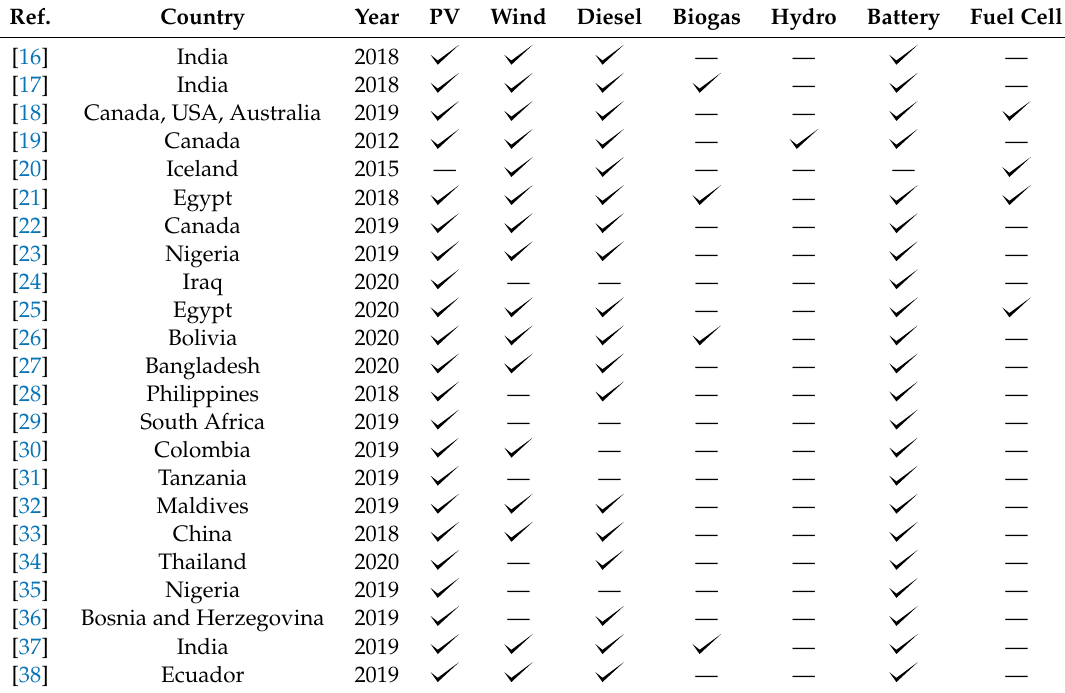
Table 1. Different microgrid configurations using